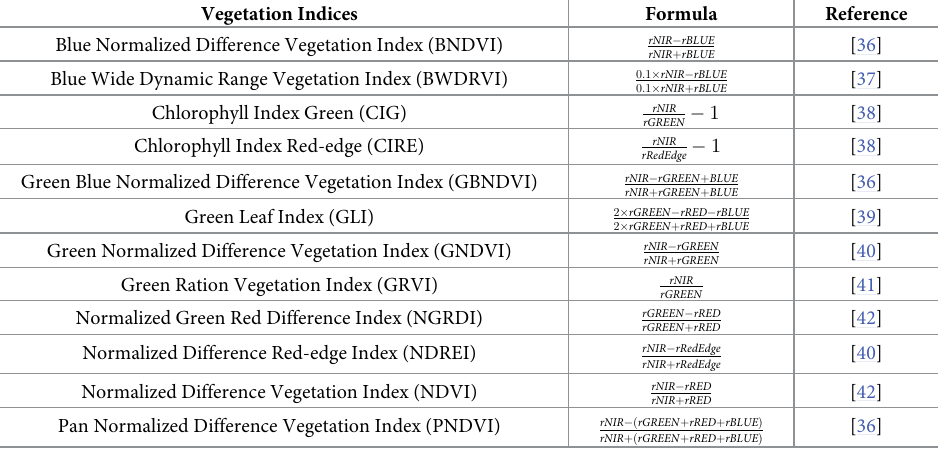
Table 3. Vegetative indices calculated for estimating cover crop termination efficiency and their respective formula. Vegetation